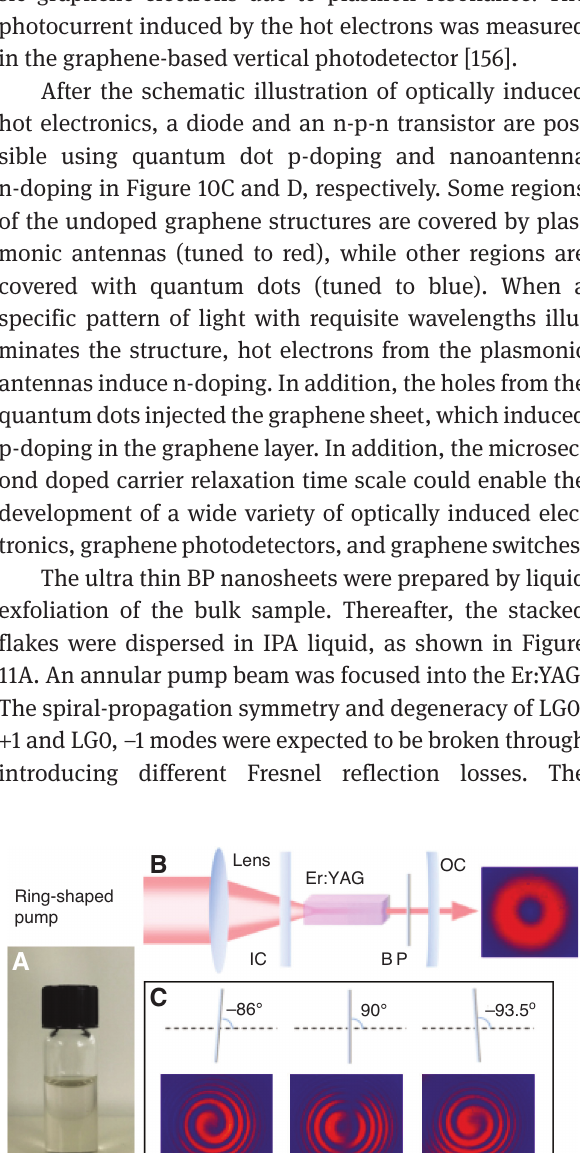
Figure 10: Phototransistor based plasmonic nonamer antenna and graphene hybrid structure [154]. (A) Nonamer antenna-graphene phototransistor. (B) FDTD calculated scattering (blue) and absorption (red) of a plasmonic nonamer. Schematic illustration of doped graphene sheet by n-doping and quantum dot p-doping, inducing (C) a diode or (D) an n-p-n transistor, respectively